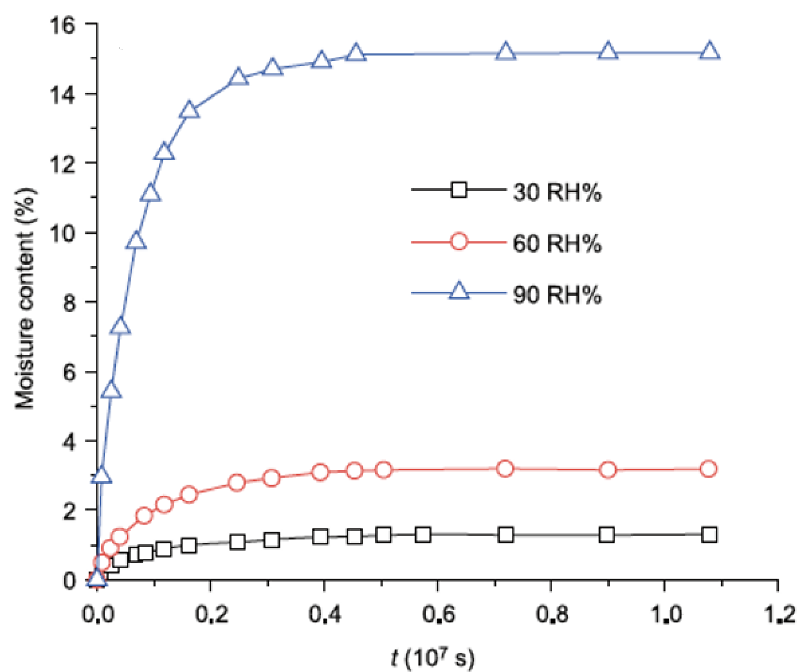
Figure 7. Experimental results on moisture absorption of sisal-fibre-reinforced composites with different relative humidities [96] (reprinted with permission from John Wiley and Sons, Licence Number: 5495871226329).